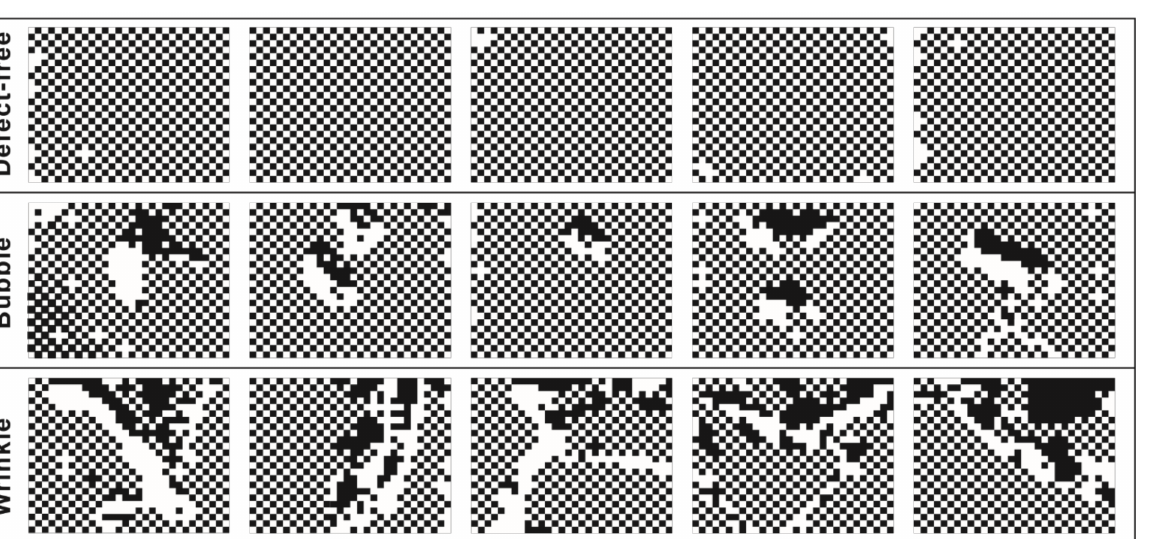
Table 3. The mean value of textural features.